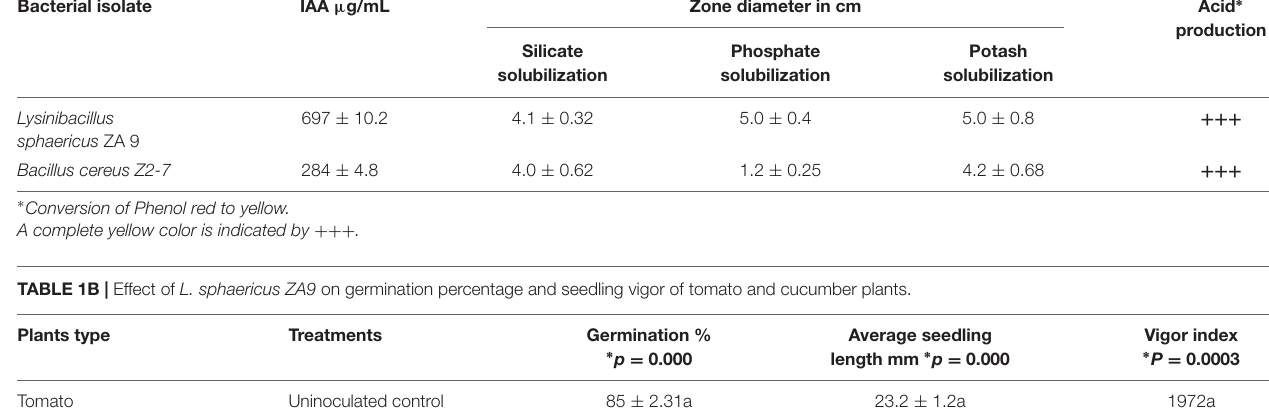
TABLE 1A | Plant growth promoting activities of Lysinibacillus sphaericus ZA9. Bacterial isolate